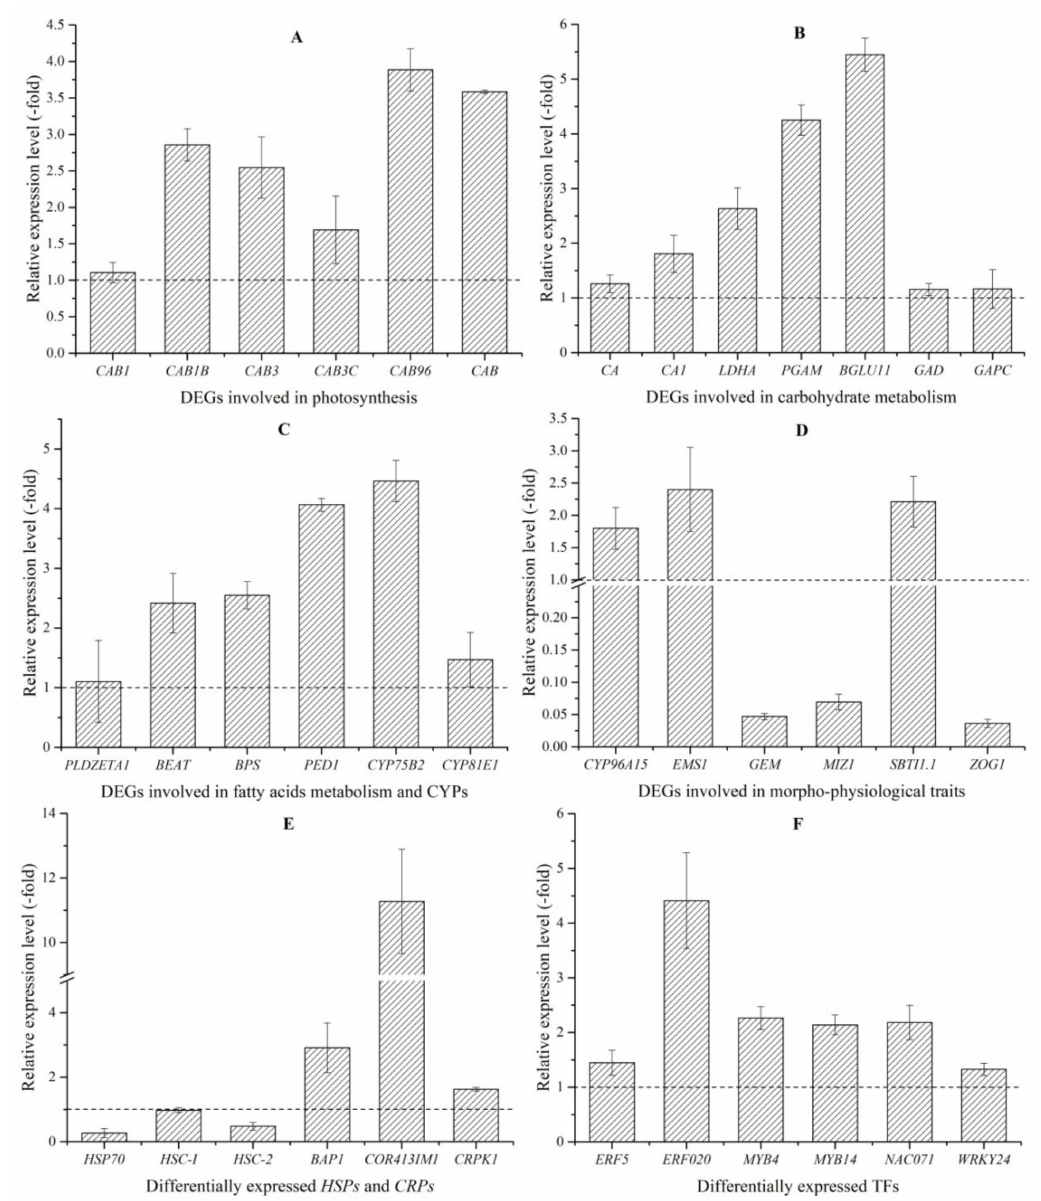
Figure 6. The expression level of genes involved in photosynthesis ( A ), carbohydrate metabolism ( B ), fatty acid metabolism and cytochrome P450 (CYPs) ( C ), morphophysiological traits ( D ), differentially expressed heat shock proteins (HSPs) and cold-responsive proteins (CRPs) ( E ) and transcriptions factors (TFs) ( F ) at 15 versus 22 ◦ C plants, as determined by